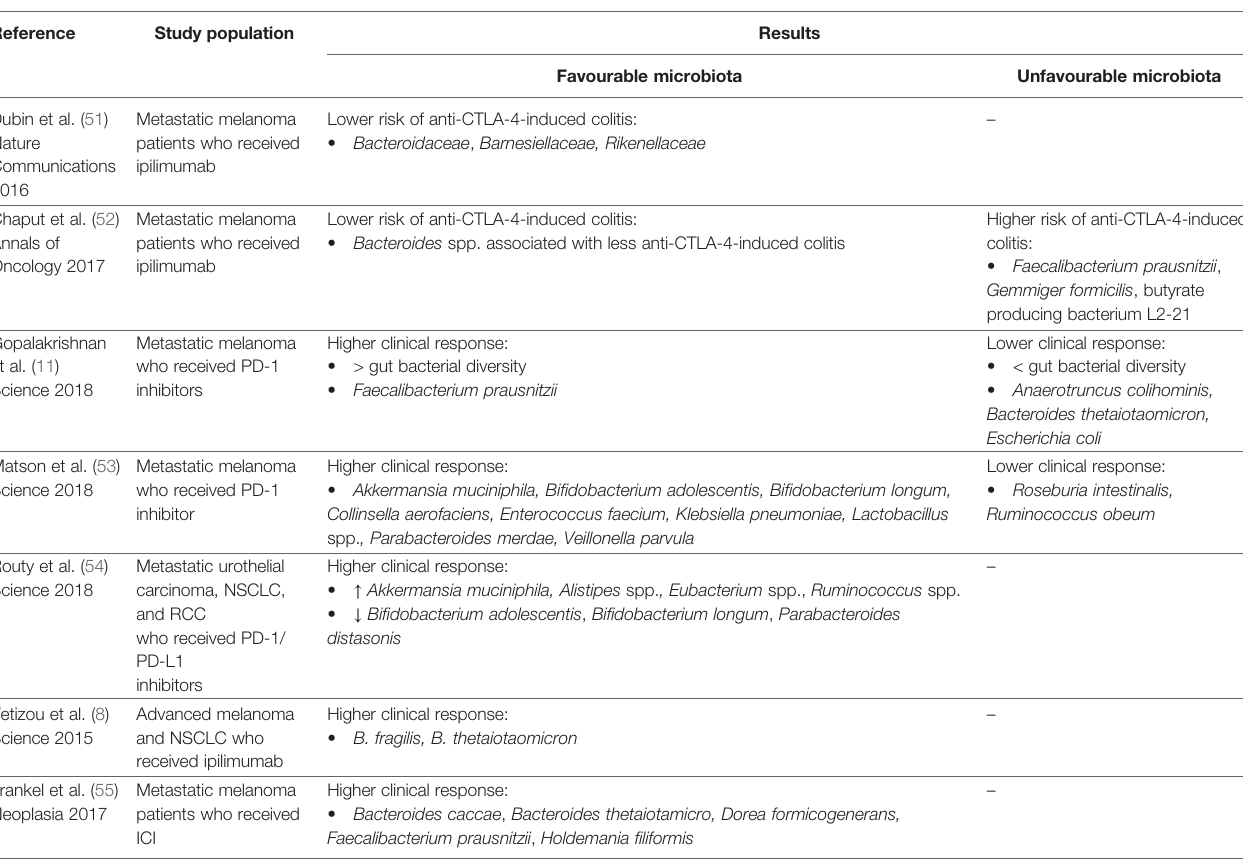
TABLE 1 | Clinical studies with association between gut microbiota and ef fi cacy/toxicity of immune checkpoint inhibitors.